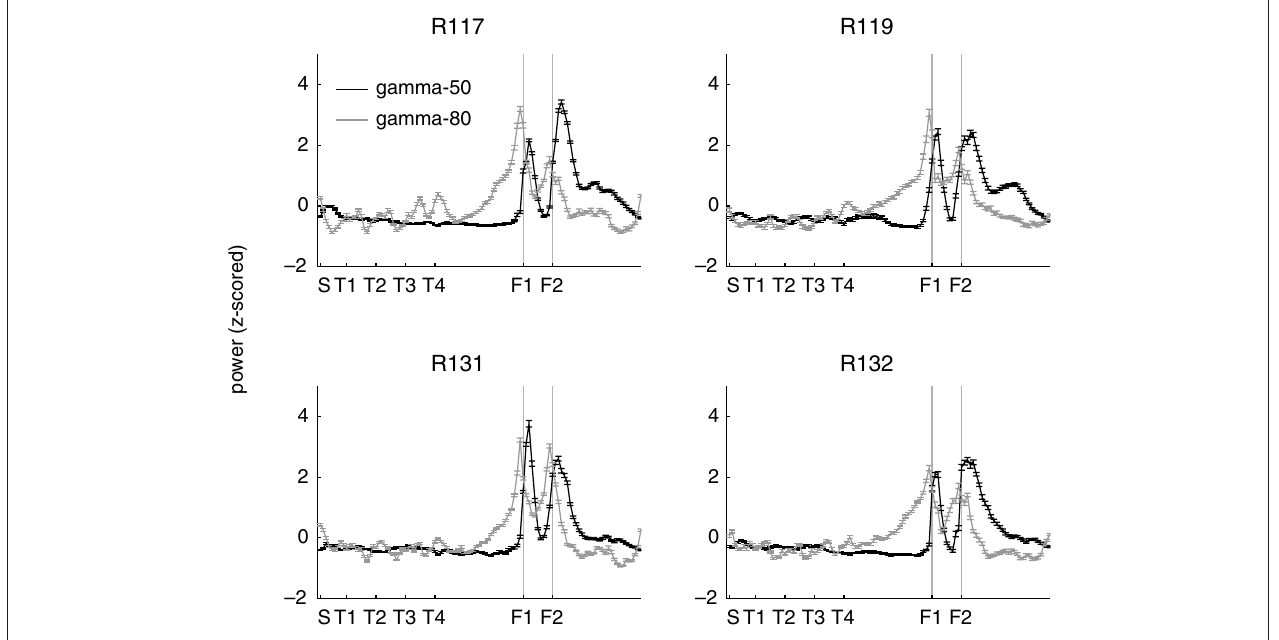
FIGURE 6 | Distinct spatial modulation of gamma-50 and gamma-80 power is consistent across subjects. Power values were z -scored across space for each session individually and plotted in black (gamma-50) and grey (gamma-80). Error bars represent SEM over